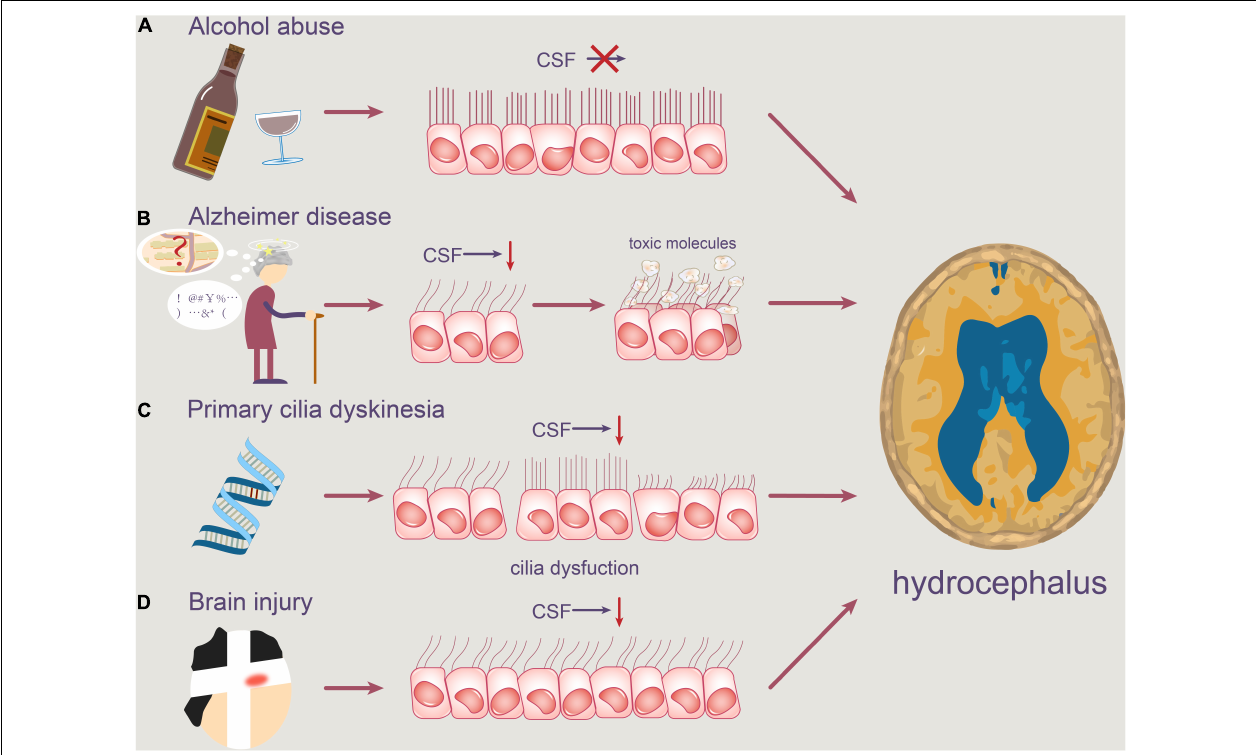
FIGURE 3 | Pathophysiology of motile cilia in hydrocephalus. Abnormal motile cilia can be caused by a variety of reasons. (A) Alcohol abuse may reduce the beating frequency of cilia, resulting in slower CSF flow. (B) Degenerative neuropathologies, such as Alzheimer’s disease, can obstruct the clearance of toxic molecules like A β , causing them to accumulate in the ventricle. (C) Furthermore, PCD patients’ ependymal cilia are unable to beat at a regular frequency, which contributes to a disruption in normal CSF circulation. (D) Concussion brain injury also contributes to the rapid shedding of ventricular ependymal cilia and the reduction of CSF flow